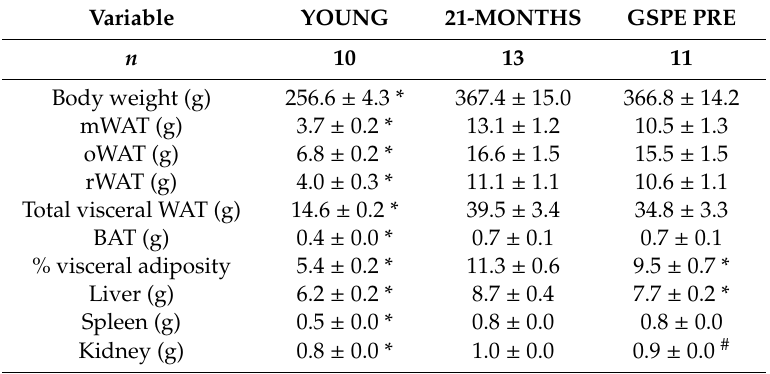
Table 1. Morphometric characteristics at the end of the experiment (week 11) .